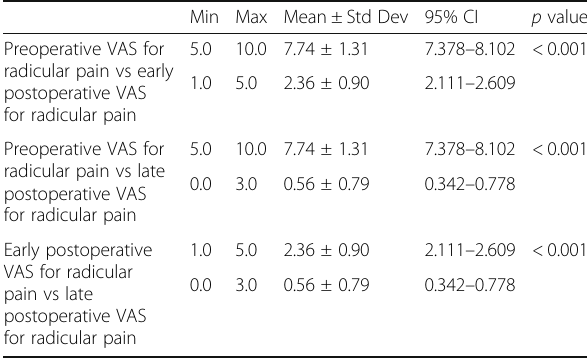
Table 1 Comparison between different values of VAS